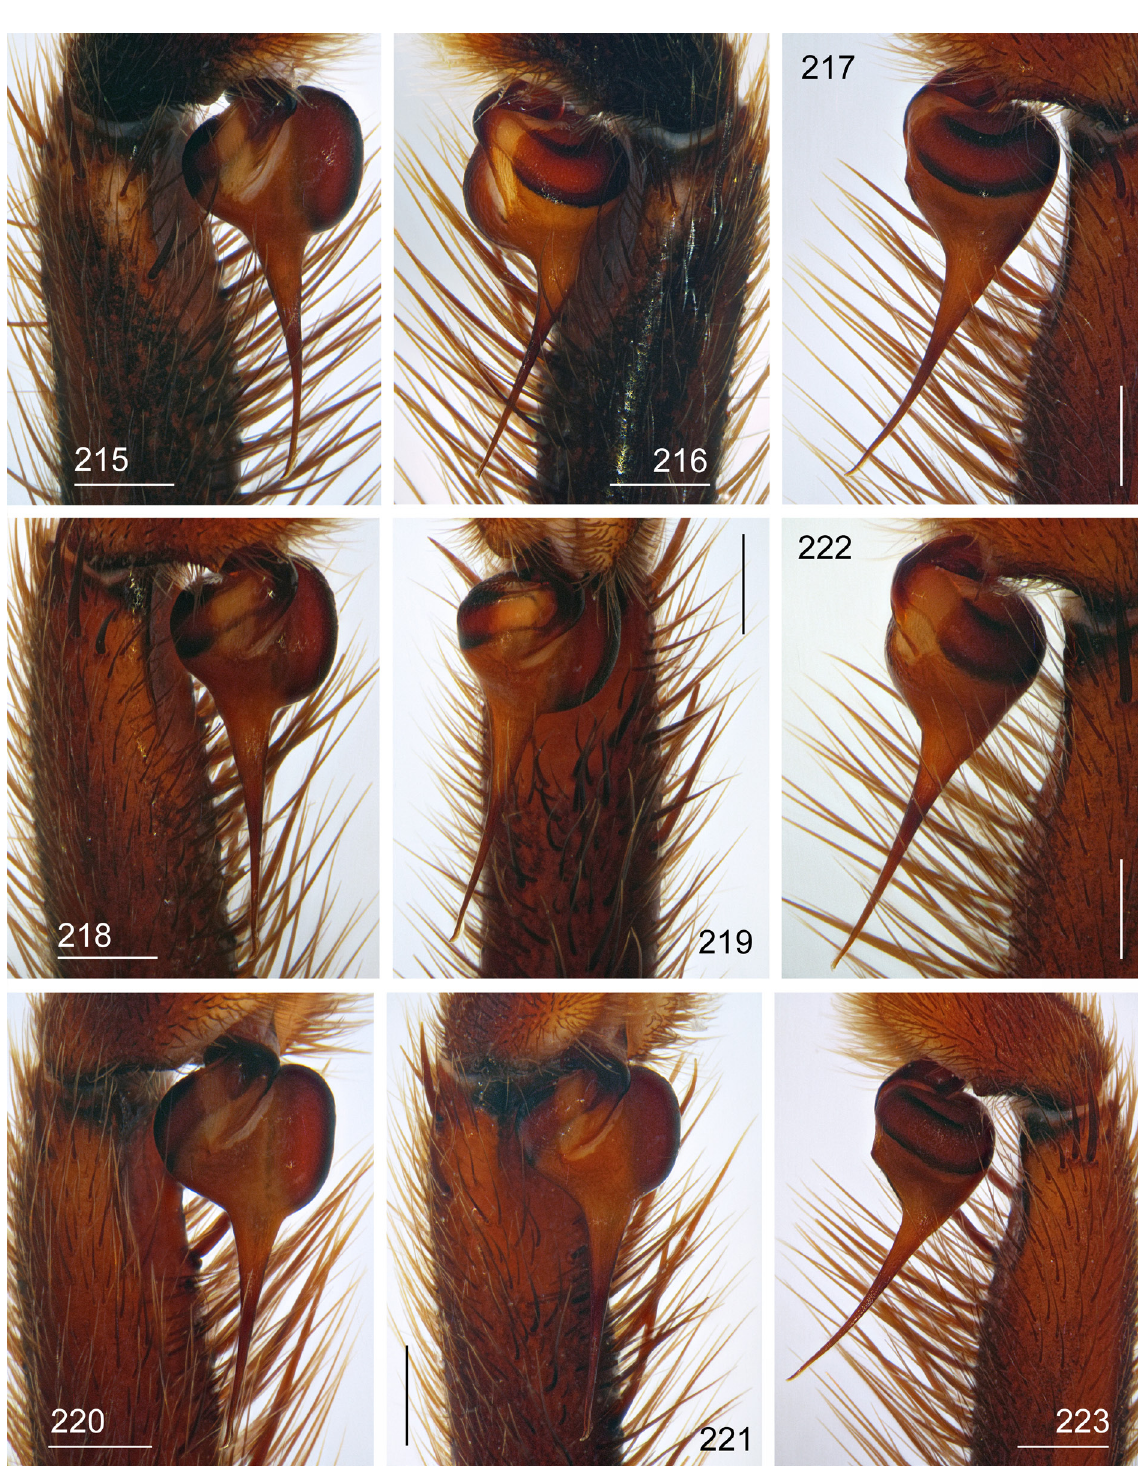
Figs 215–223. Anemesia spp., ♂♂, details of palpal organ; ventral (215, 218–221, 213) and retrolateral (216–217, 222–223) views. 215–216 . A. incana Zonstein, 2001 (holotype). 217–219 . A. infumata sp. nov. (holotype). 220–221, 223 . A. infuscata sp. nov. (holotype). 222 . Same (paratype from Sanglok Mts). Scale bars: 0.5